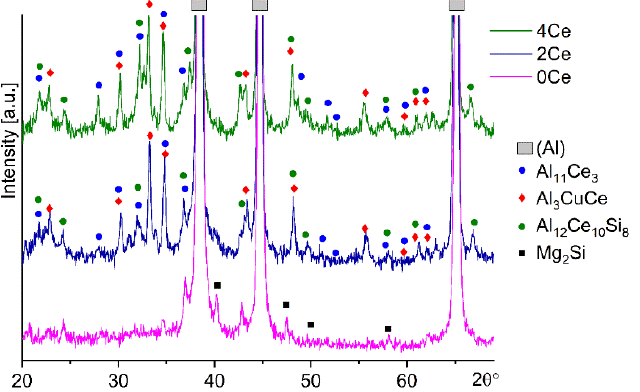
Figure 1. The XRD data for the studied alloys after a two-step homogenization annealing.